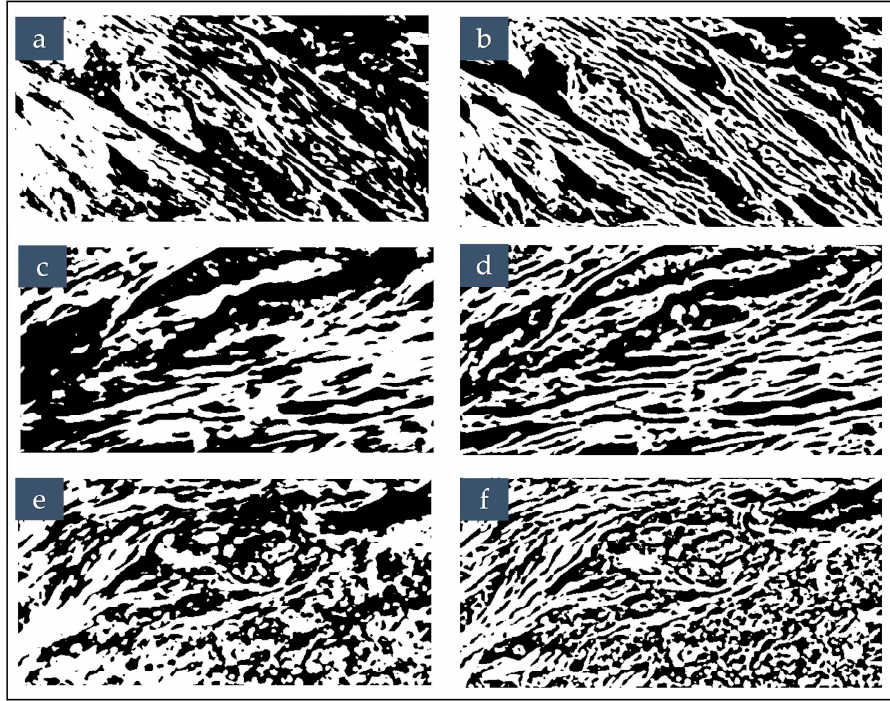
Figure 3. Thresholding ( a , c , e ) vs. semantic ( b , d , f ) segmentation methods. Examples of comparisons on homologous slices: ( a , b ) Ctr1_st_wt; ( c , d ) Ctr2_lt_no-wt; ( e , f ) Pt2_st_no-wt_l.